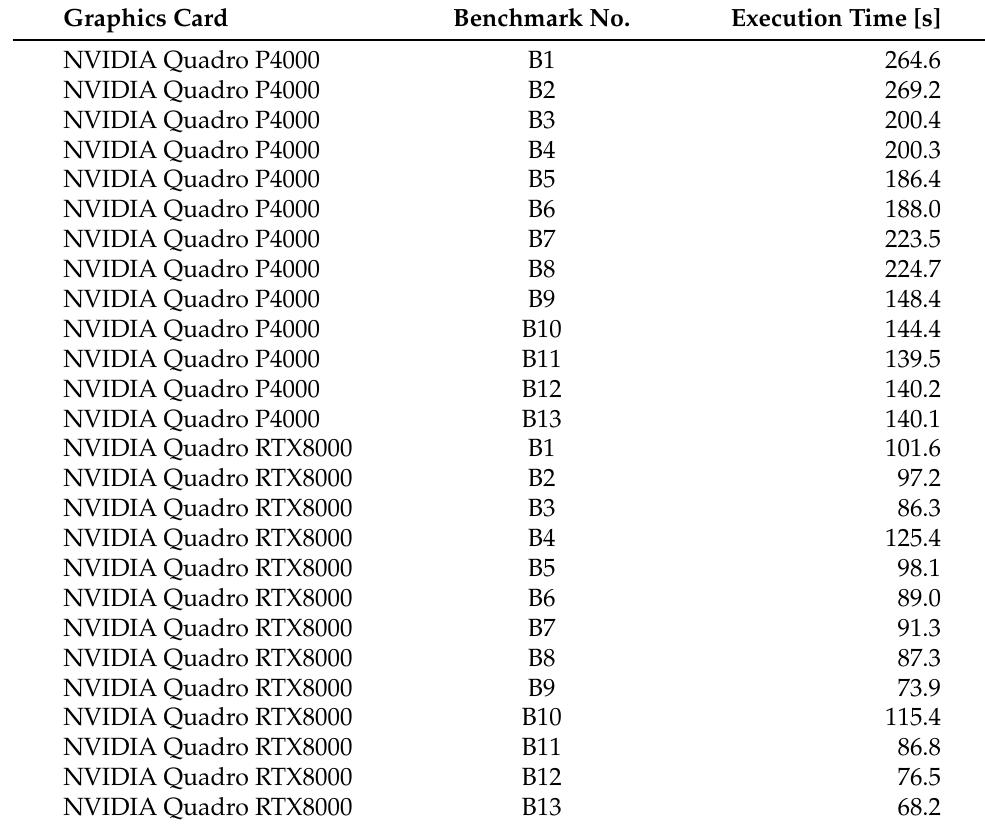
Table 2. Processor time of backprojection for different benchmarks. Averaged over four